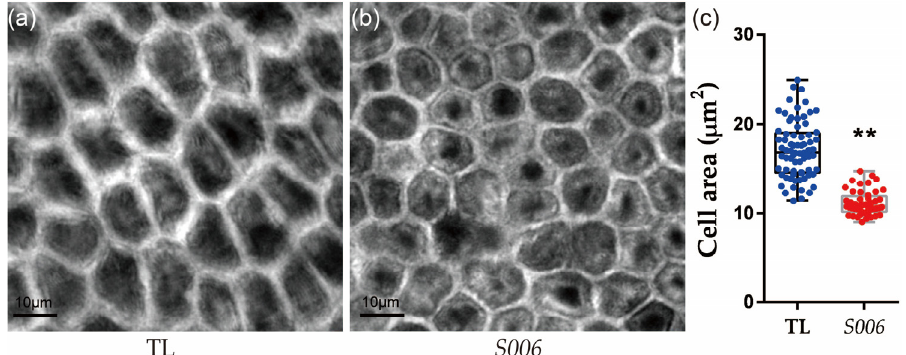
Figure 2. Comparison of seed-integument cells between S006 and wild-type plants. ( a ) Image of integument cells in wild type; ( b ) image of integument cells in S006 mutant; ( c ) statistical analysis of cell area of S006 and wild-type seeds. Asterisks indicate a significant difference according to Student’s t -test (**, p < 0.01).